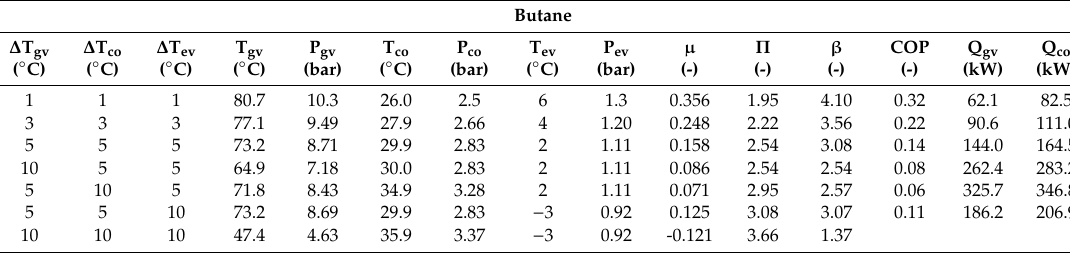
Table A6. Thermodynamic analysis results for Butane